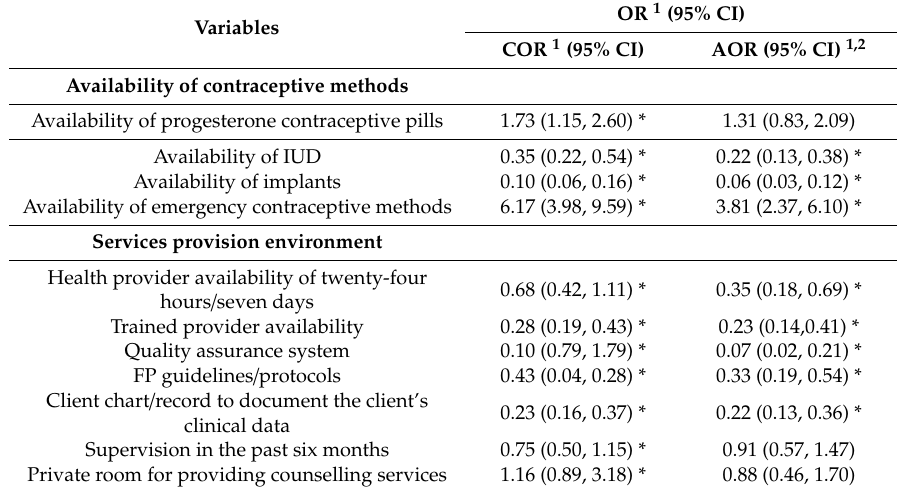
Table 1. Unadjusted and adjusted regression model for comparing structural quality of services